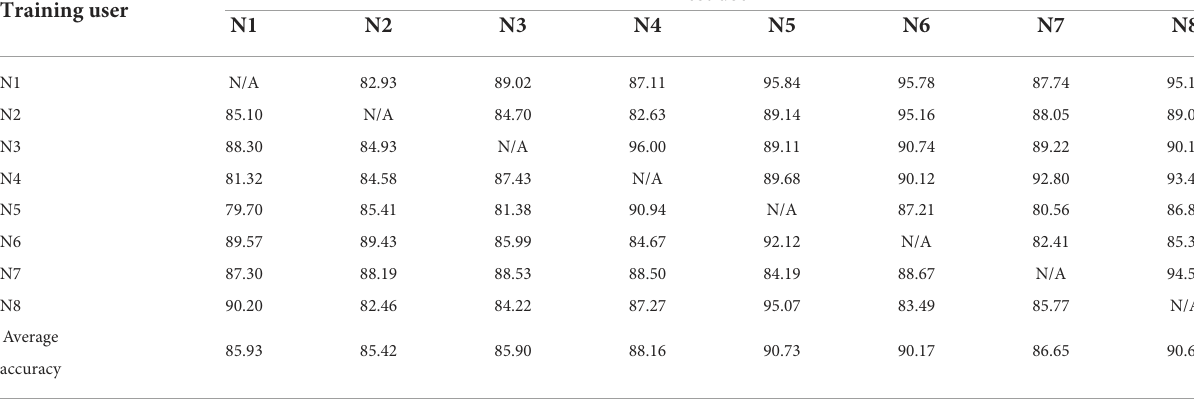
TABLE 2 Experimental results for user-independent CCA-without-ADR framework.